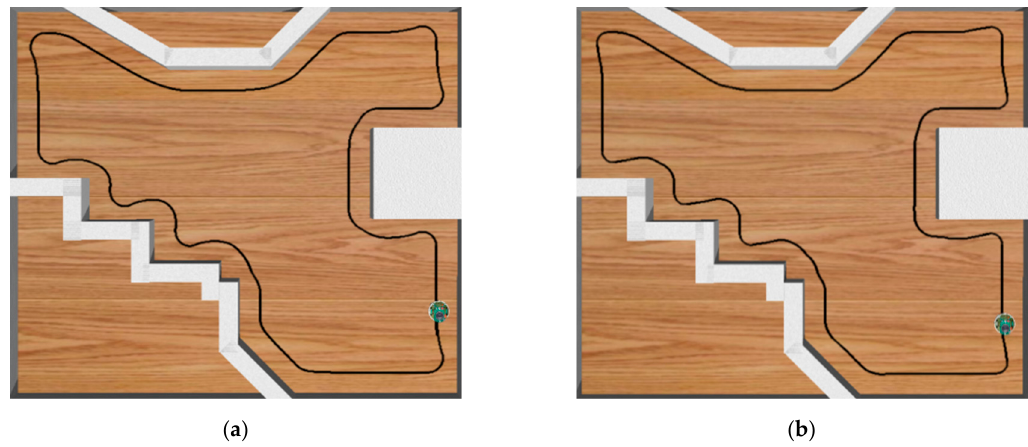
Figure 18. Moving path of the robot in the testing environment 2: ( a ) DGDE-1 and ( b ) DGDE-2.